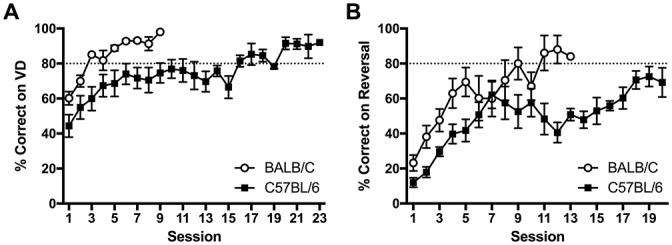
Acquisition curves showing learning rate in BALB/c and C57BL/6 mice on (A) VD and (B) reversal. Mice started near chance 50% on VD but all mice went on to reach criteria of >80% correct. Upon reversal % correct dropped to around 20% and five C57BL/6 mice did not acquire reversal within 20 sessions (white circles are BALB/c, black squares are C57BL/6).